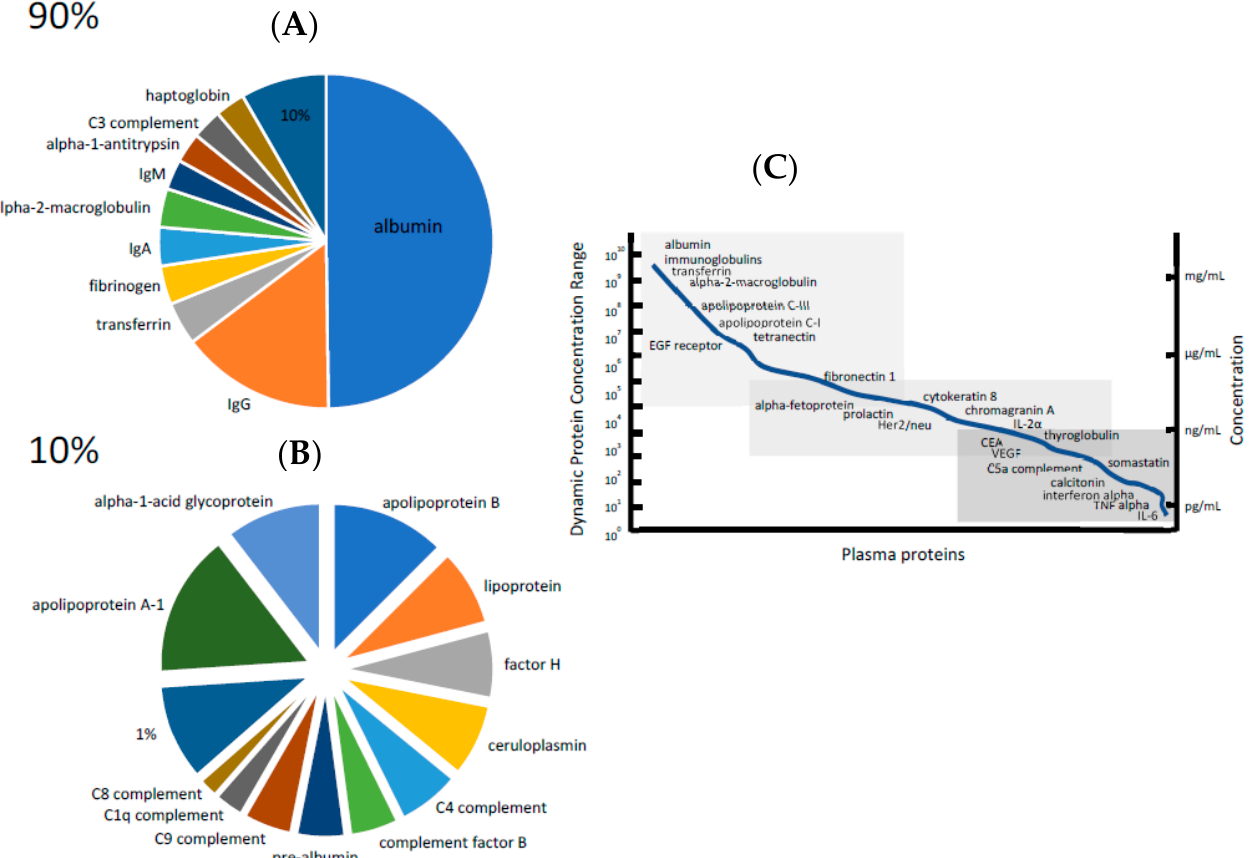
Figure 1. ( A ) Approximately 90% of the protein content of these samples is made up of only 22 proteins, with albumin making up between almost half of the total amount. ( B ) Separation strategies to characterize serum and plasma focus on methods to enable proteins within the lower 10% concentration level to be identified. ( C ) The dynamic range of protein concentration of serum and plasma is very broad, covering approximately 12 orders of magnitude. Adapted from